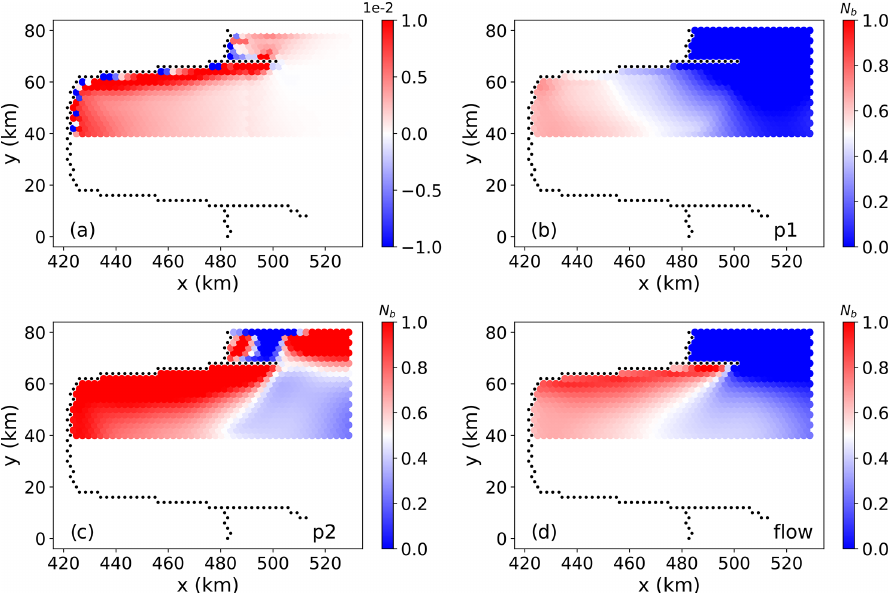
Figure 2. GLF number and buttressing number for each of the 730 perturbed grid cells in the MISMIP + experiments. (a) The spatial distribution of the GLF response number, N rp . (b–d) The spatial distribution of the buttressing number, N b , corresponding to directions (b) n p1 , (c) n p2 , and (d) n f . Black dots indicate grid cells located along the grounding line. Here the color bars for (a) – (d) do not show the full data range. Note that the negative GLF numbers in panel (a) are due to the nonlinear impacts of changes in both ice thickness and velocity at the